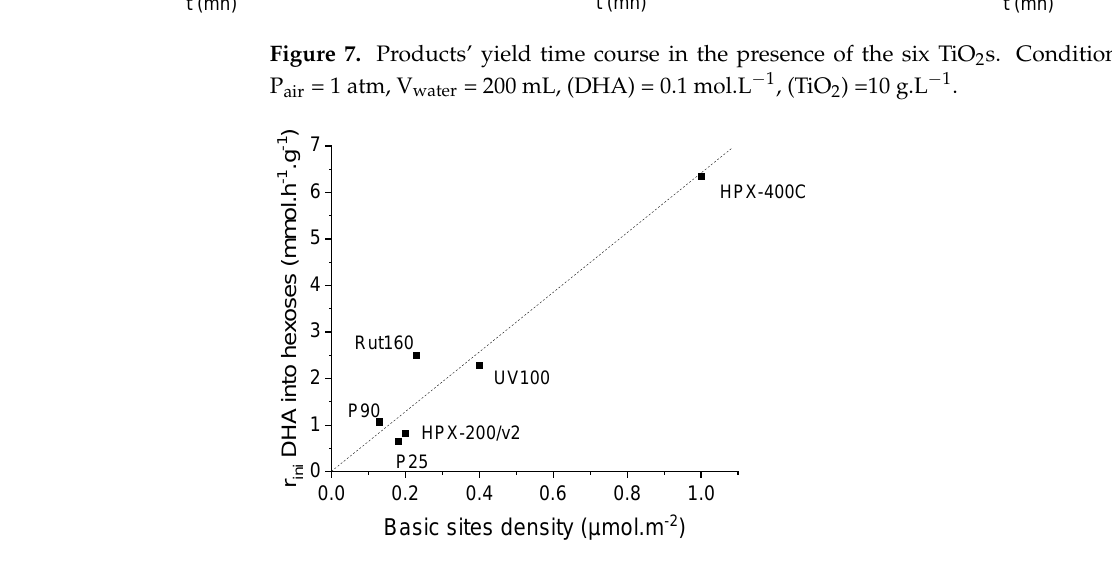
Figure 8 . Increase of initial rate of hexoses formation as a function of TiO 2 ′ s basic sites density. Figure 8. Increase of initial rate of hexoses formation as a function of TiO 2